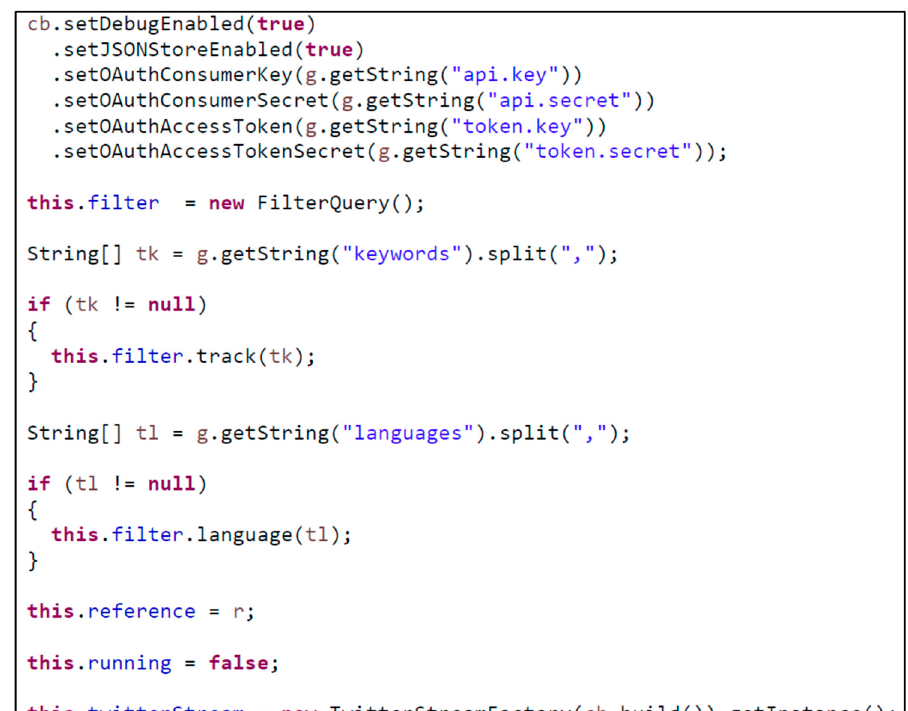
Figure 3. The code of a filter for Twitter messages selecting messages on the basis of the language and the presence of keywords.